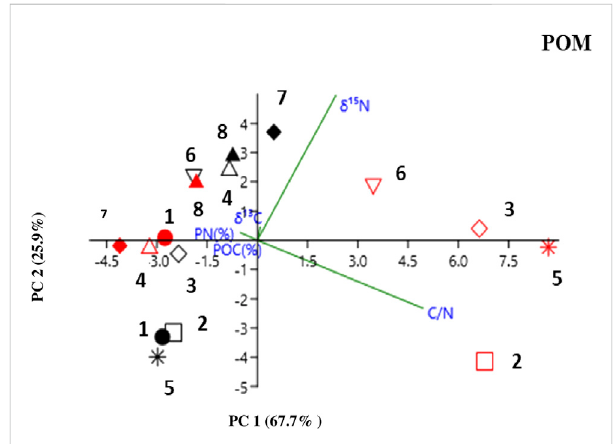
FIGURE 3 PCA results using the elemental and isotopic composition from the fall and spring season samples. Individual sampling sites are indicated by their site number. Black color represents the fall season, andredcolorrepresentsthespringseason(theshapesre fl ectthe site numbers: dot: site1, square: site 2, diamond: site 3, triangle: site4,